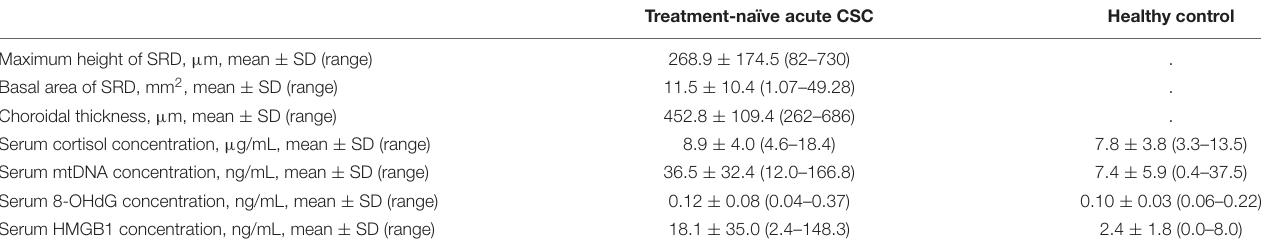
TABLE 2 | Clinical and labo data of treatment-naïve acute CSC patients and healthy.